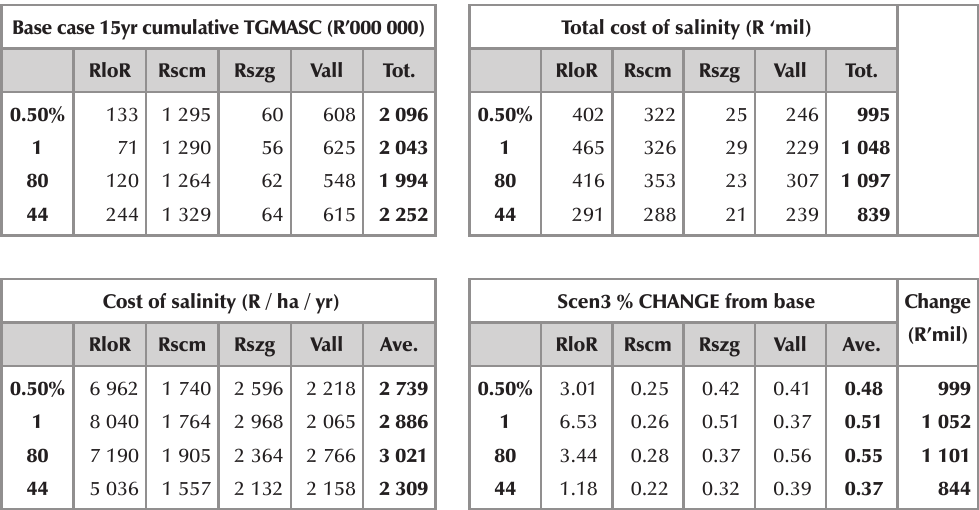
A summary of various SMsim model results comparing stochastic runs 001, 080 and 044 and the 0.50 percentile value of the 100 stochastic runs (2005